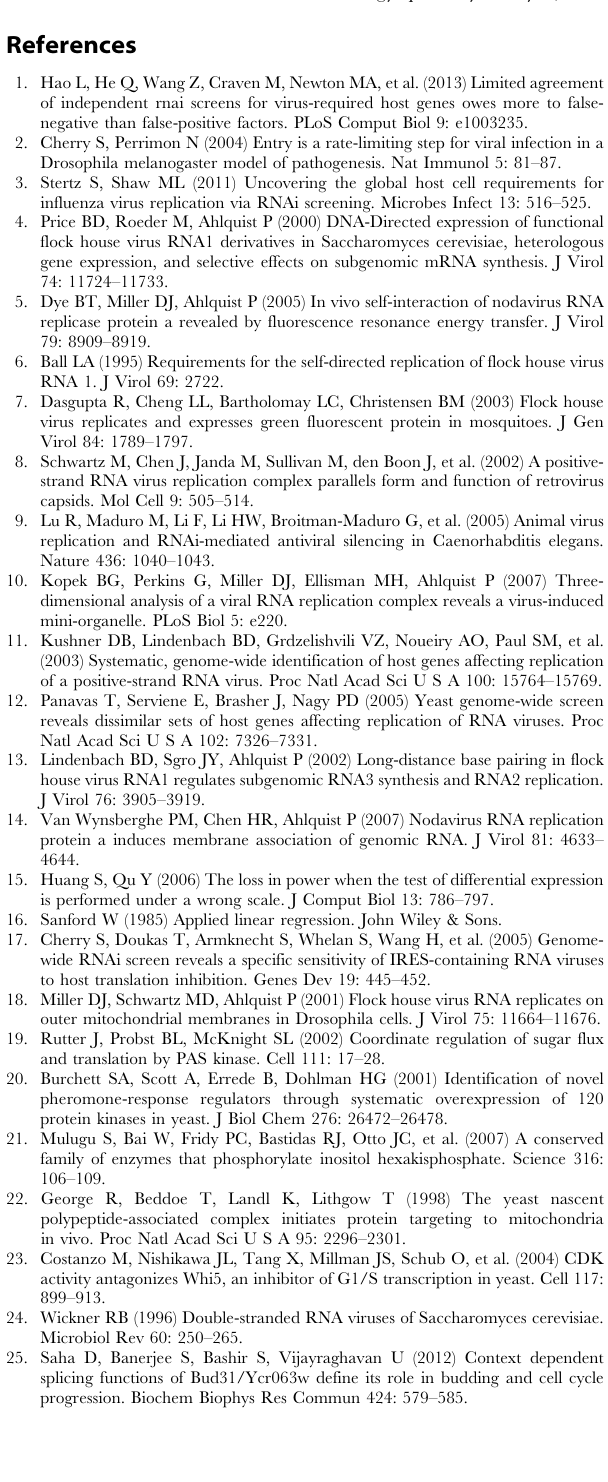
Table S1 Whole screen data for FHV replication in yeast knockout library